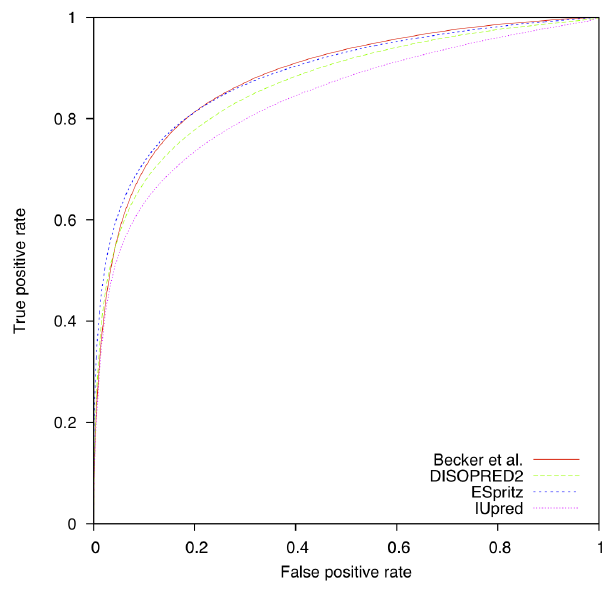
Figure 6. ROC curves on PDB30 dataset. ROC curve of our method (Becker et al. ) and three freely downloadable predictors: DISPRED2